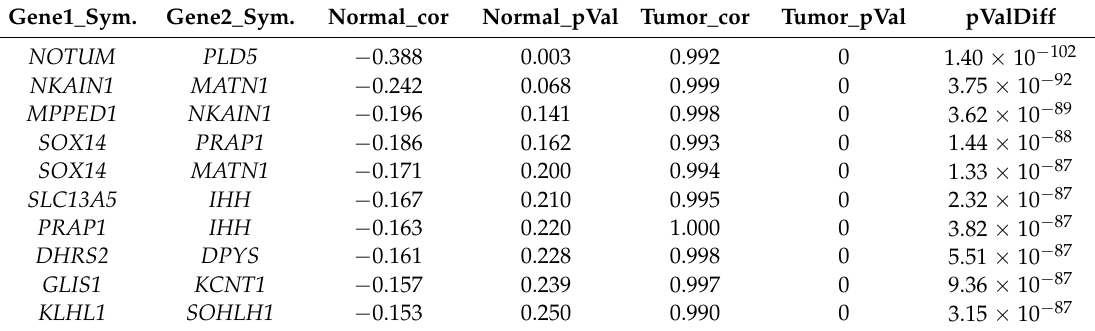
Table 1. Summary of the top 10 significant differential gene co-expressions identified by DGCA. Gene1_Sym.